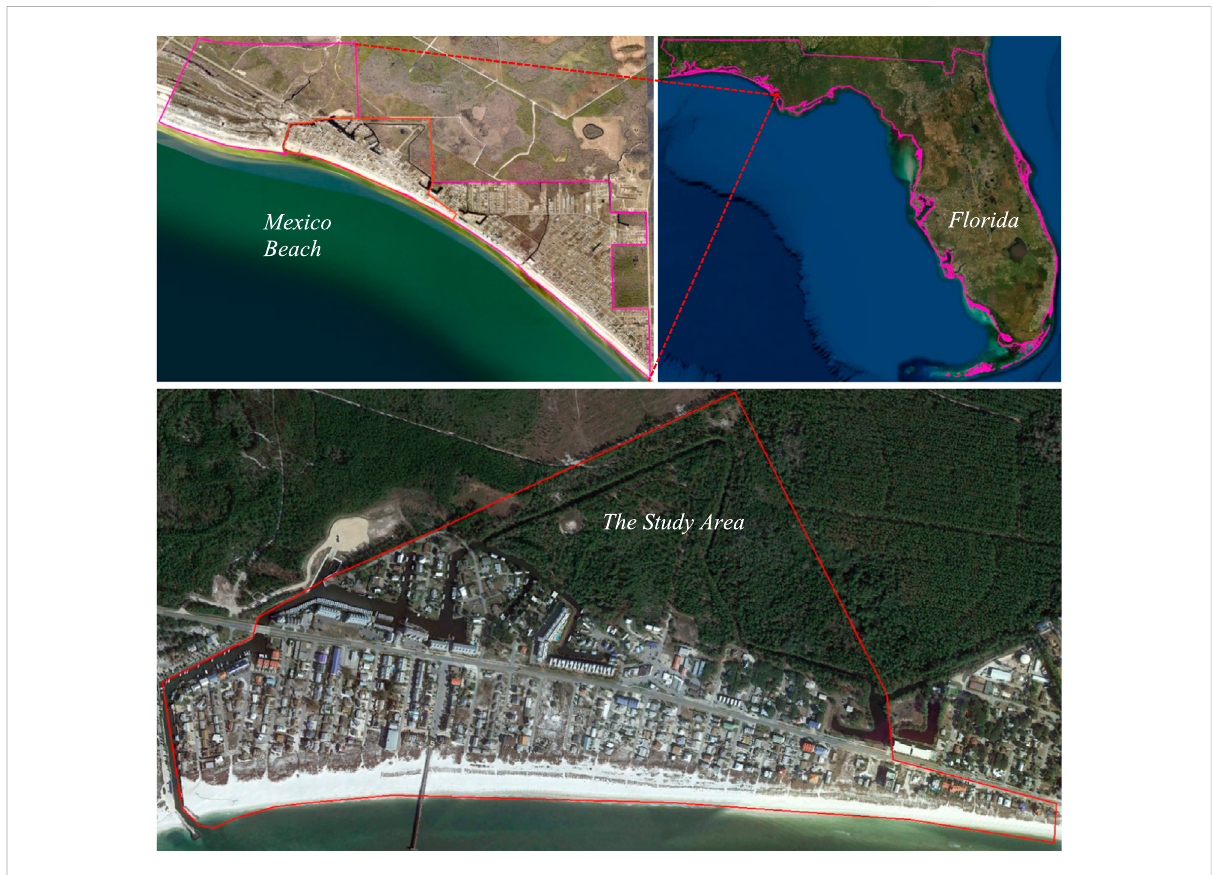
FIGURE 8 The geographical location of Mexico Beach with respect to the state of Florida with a close-up view on the chosen study area within Mexico Beach,